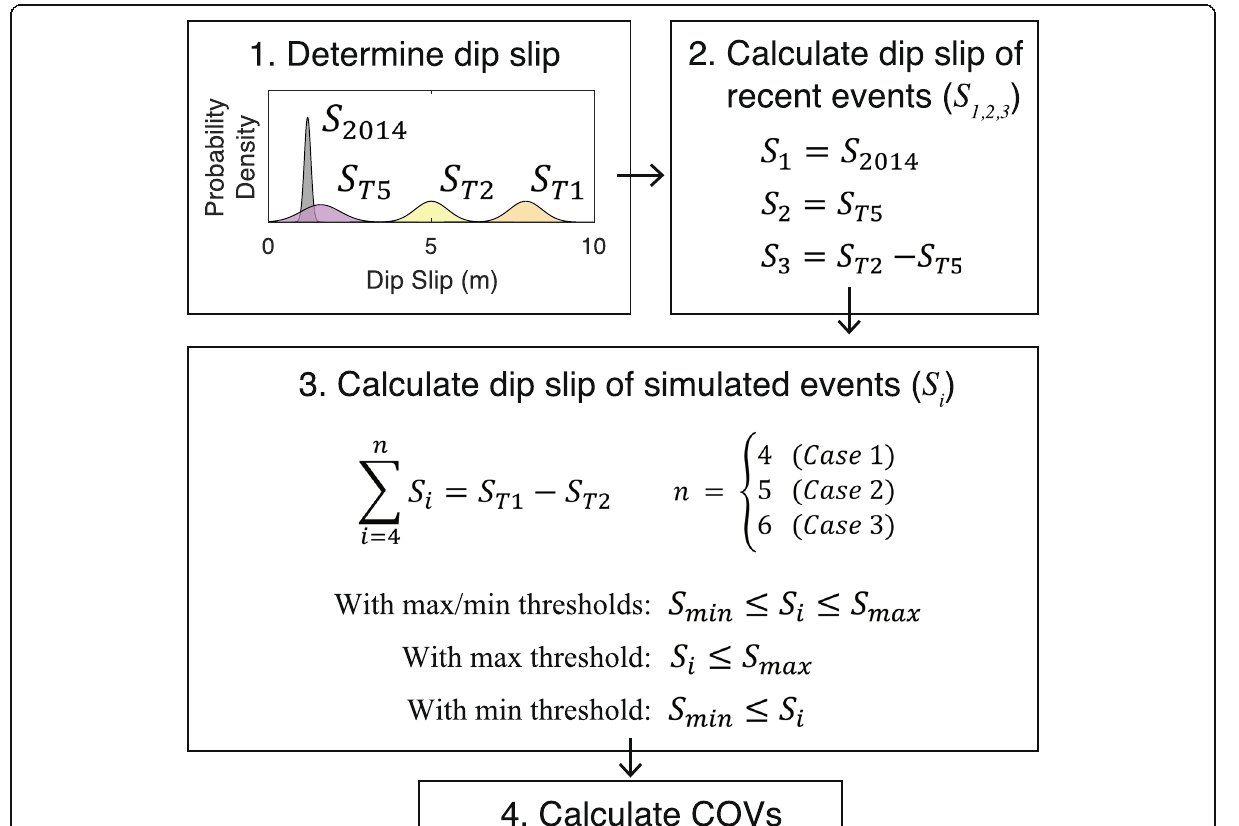
Fig. 11 Flowchart illustrating the procedure to calculate the COVs. S 2014 is the dip slip of the 2014 event. S T 1, T 2, T 5 is the dip slip of terraces T1, T2, and T5; they do not include that of the 2014 event. S i is the dip slip of the i th most recent event at the Oide